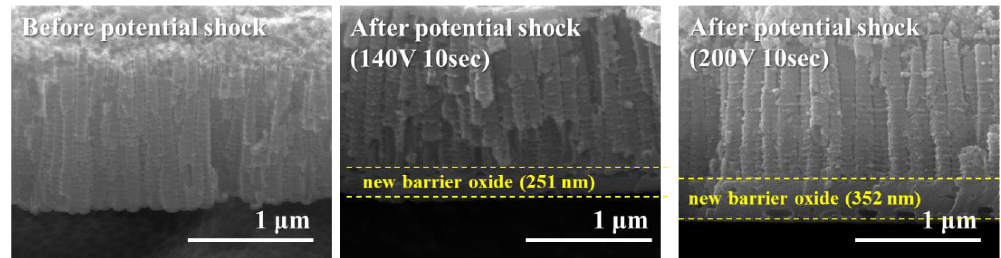
Figure 5. Cross-sectional scanning electron microscopy (SEM) images of RuO 2 -doped TiO 2 nanotubes prepared by the potential shock method. At the bottom of the tubes, additional barrier oxide